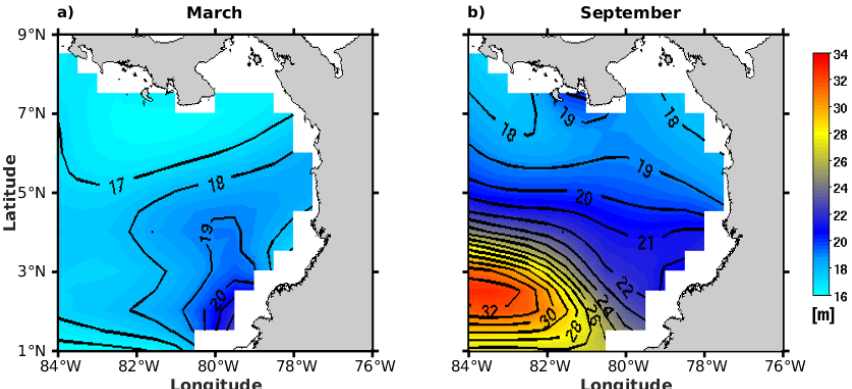
Figure 6. Climatology (2002–2016) of the mixed layer depth (in color scale) for ( a ) March and ( b ) September. Gray (dark red) shading represents the regions with a shallow (deep) mixed layer.